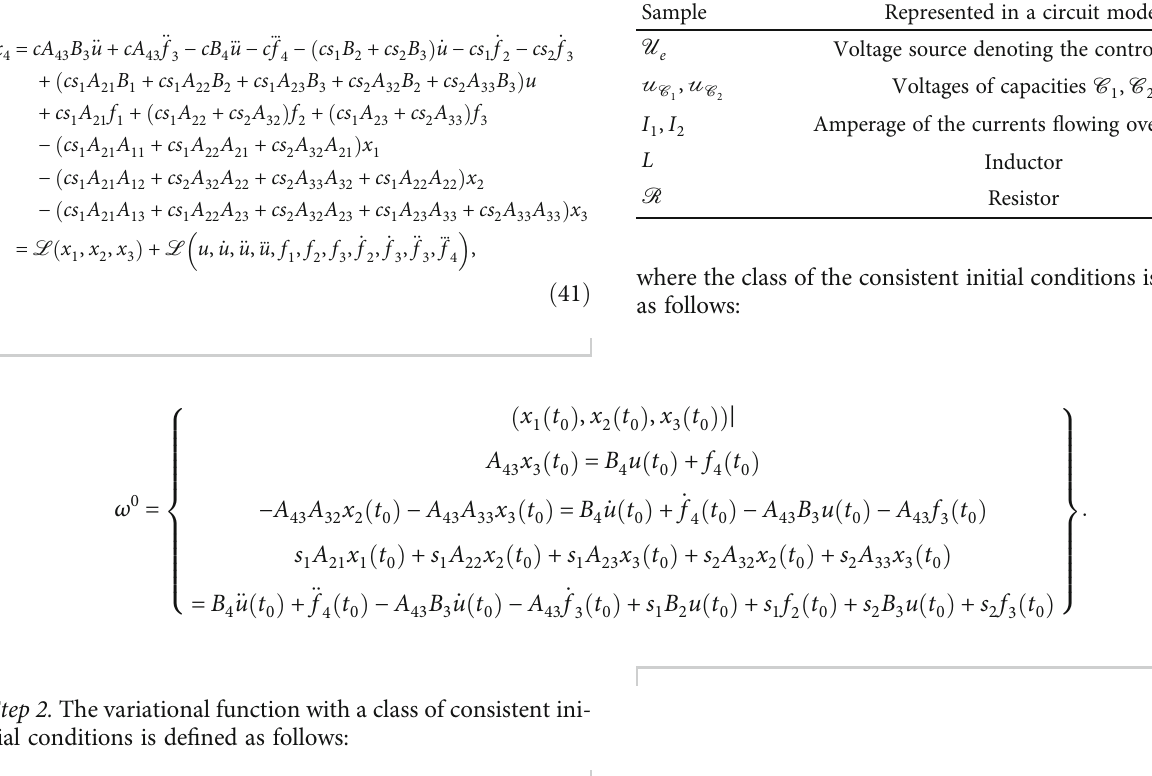
Sample Represented in a circuit